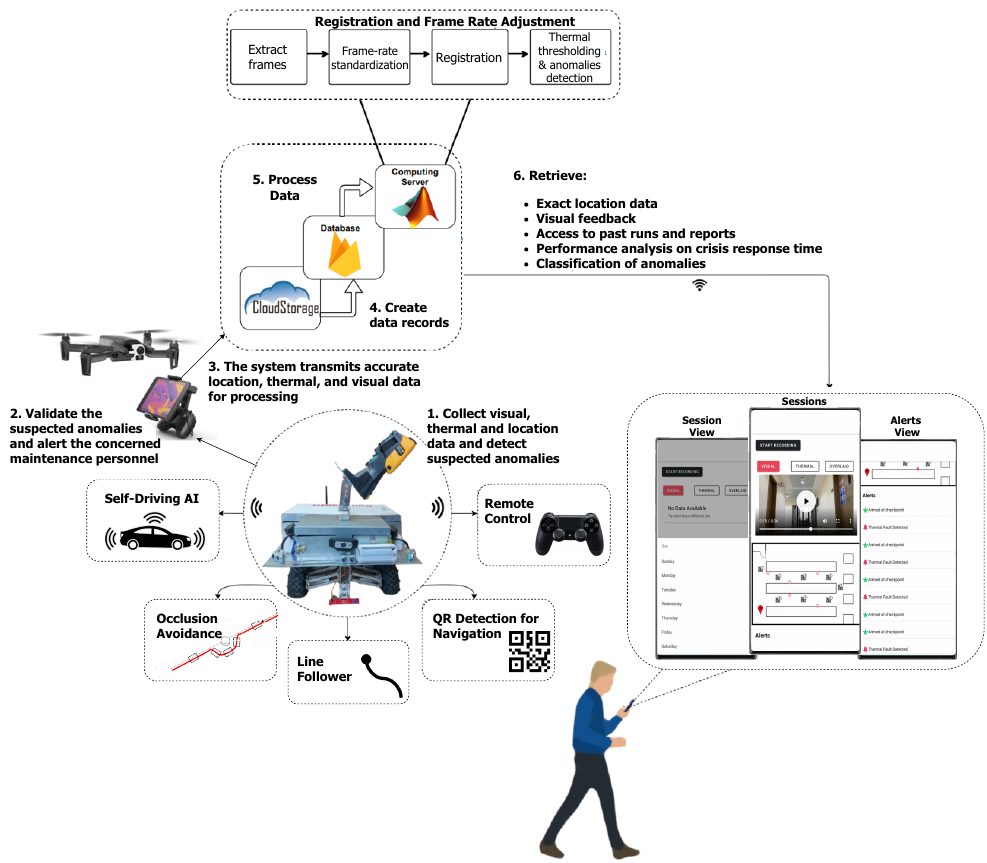
Figure 4. Proposed system